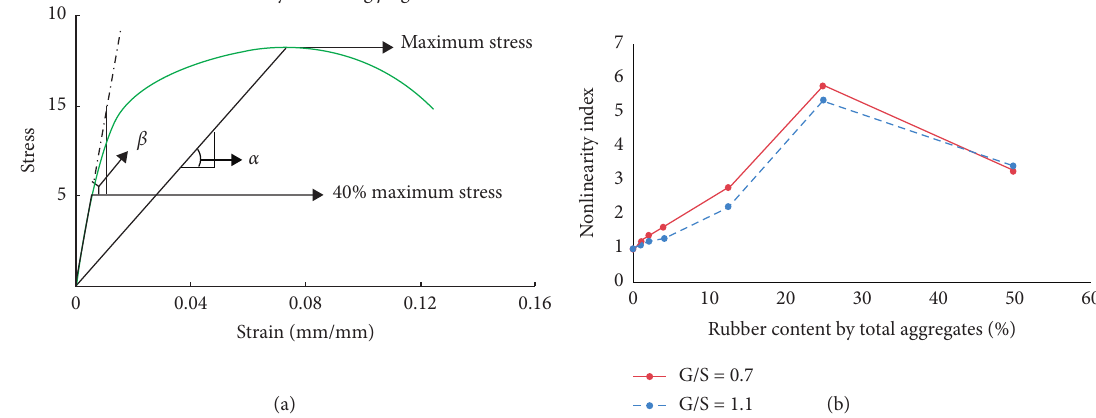
Figure 9: (a) Evaluation of nonlinearity index. (b) Nonlinearity index for HSRC specimens at 28